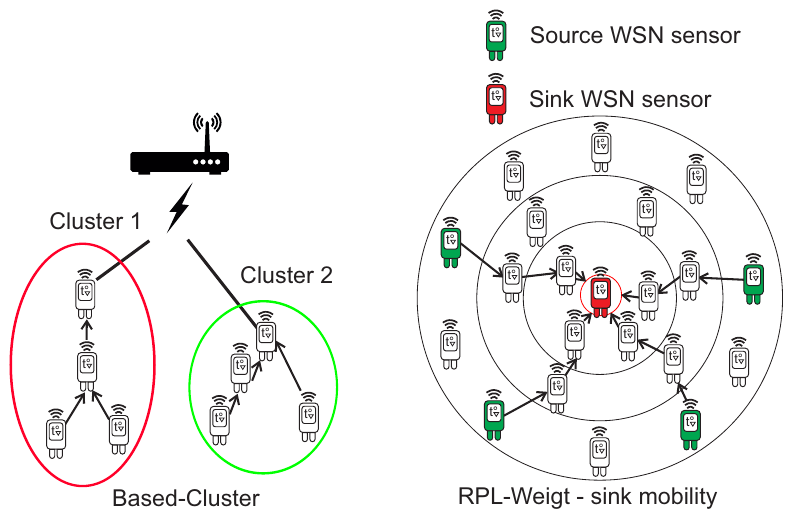
Figure 8. The example of Based-Cluster and RPL-Weight routing